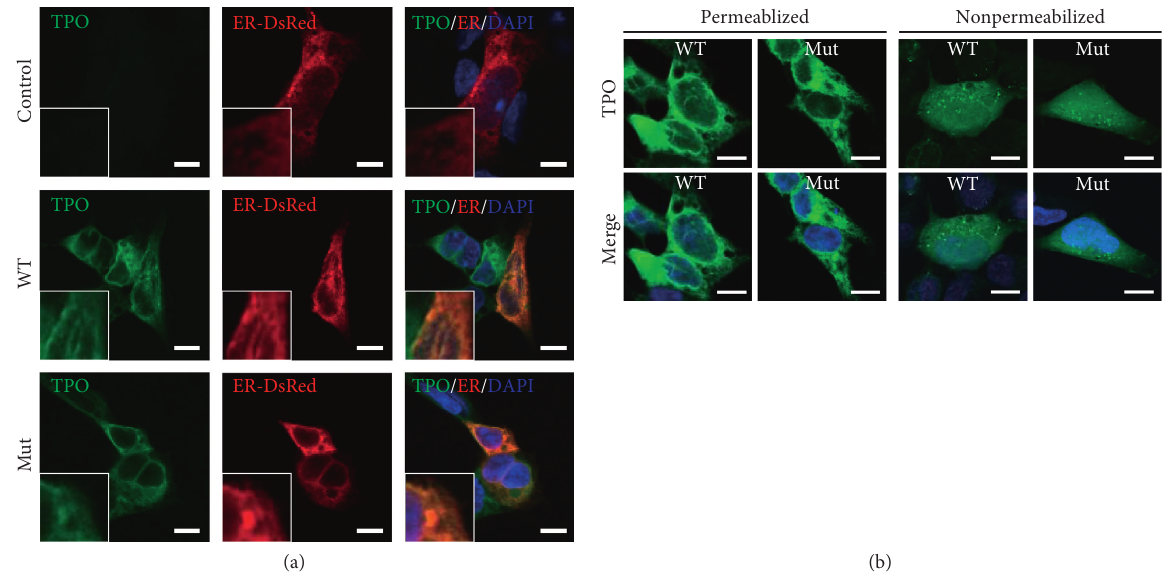
Figure 5: Immunocytochemical analysis of HEK293 cells. Location of wild-type and mutant TPO proteins. To determine the localization of TPO protein, immunofluorescence experiments were performed. Fluorescence was detected in the cells expressing wild-type TPO (WT), p.Cys655Phe (Mut) in both permeabilized and unpermeabilized conditions. (a) Compared under the condition of nonpermeabilized, TPO was localized in the endoplasmic reticulum in both WT and Mut. Cells transfected with the empty vector (control) did not show TPO fluorescence. The TPO is green, the endoplasmic reticulum is red, and the nucleus is purple. (b) WT and Mut were compared under the permeabilized condition (left) and the nonpermeabilized condition (right). There was no significant difference in the localization of TPO between the two types of cells. The presence of TPO was confirmed on the cell membrane surface under nonpermeabilized conditions and on the endoplasmic reticulum under permeabilized conditions. The white bar shows 10 μ